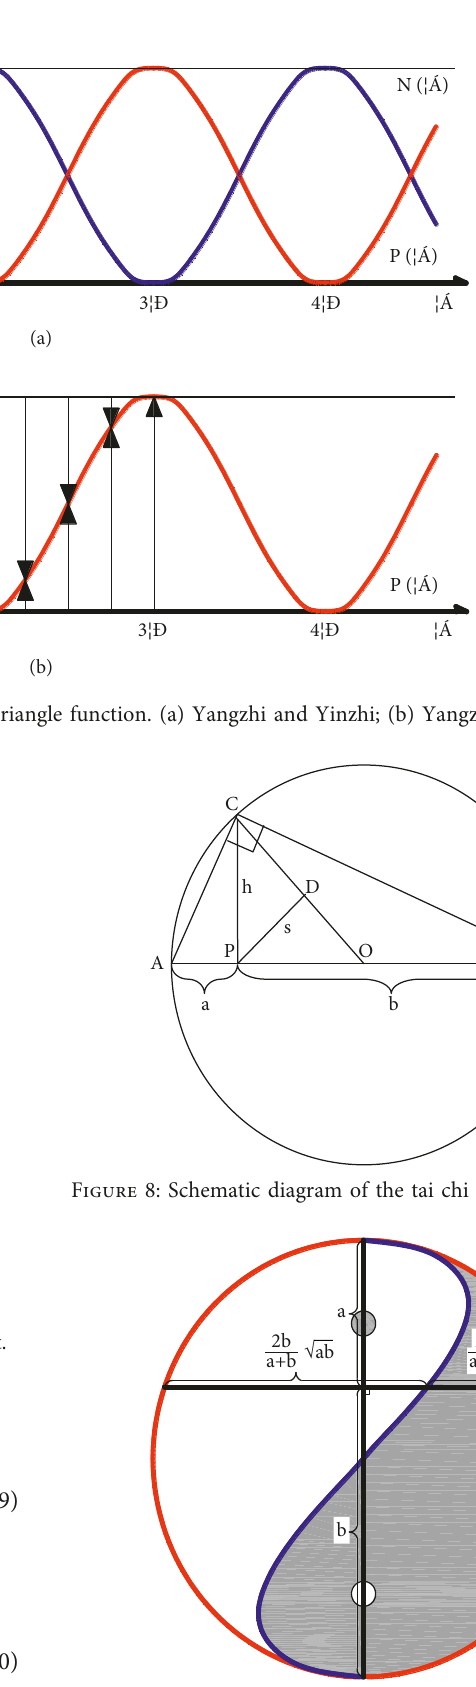
Figure 9: Mathematical model of the Taiji